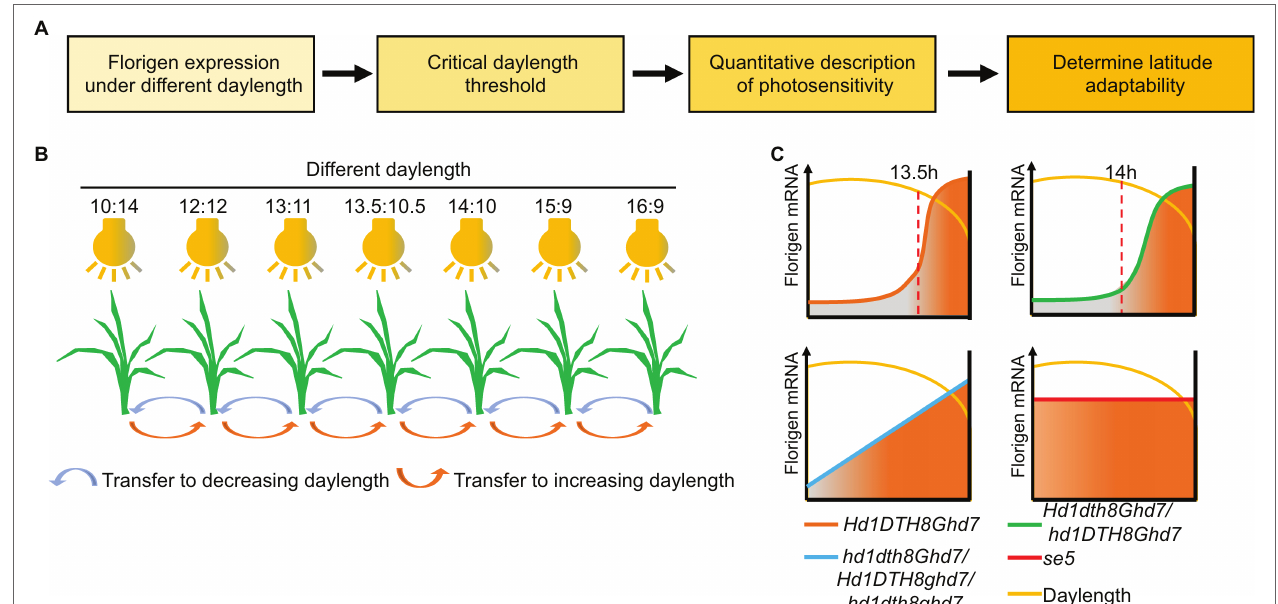
FIGURE 5 | Process and application of the daylength recognition model based on florigen. (A) Flowchart of the daylength-sensing-based environment adaptation simulator (DEAS) system. (B) Schematic diagram of the DEAS system. Plants are sown and grown in greenhouses under different photoperiods. After a given number of days, plants are transferred to the next shorter or longer daylength in the series to simulate daylength changes in nature. By detecting the expression of florigen genes under different daylengths, the critical daylength threshold can be obtained. (C) Critical daylength sensing and florigen expression changes in different rice genotypes. When daylength is shorter than the critical daylength, the florigen gene is highly expressed. Orange line, cultivars with original critical daylength sensing; green line, cultivars with fine-tuned daylength sensing; blue line, cultivars with gradual daylength sensing; and red line, cultivars with daylength